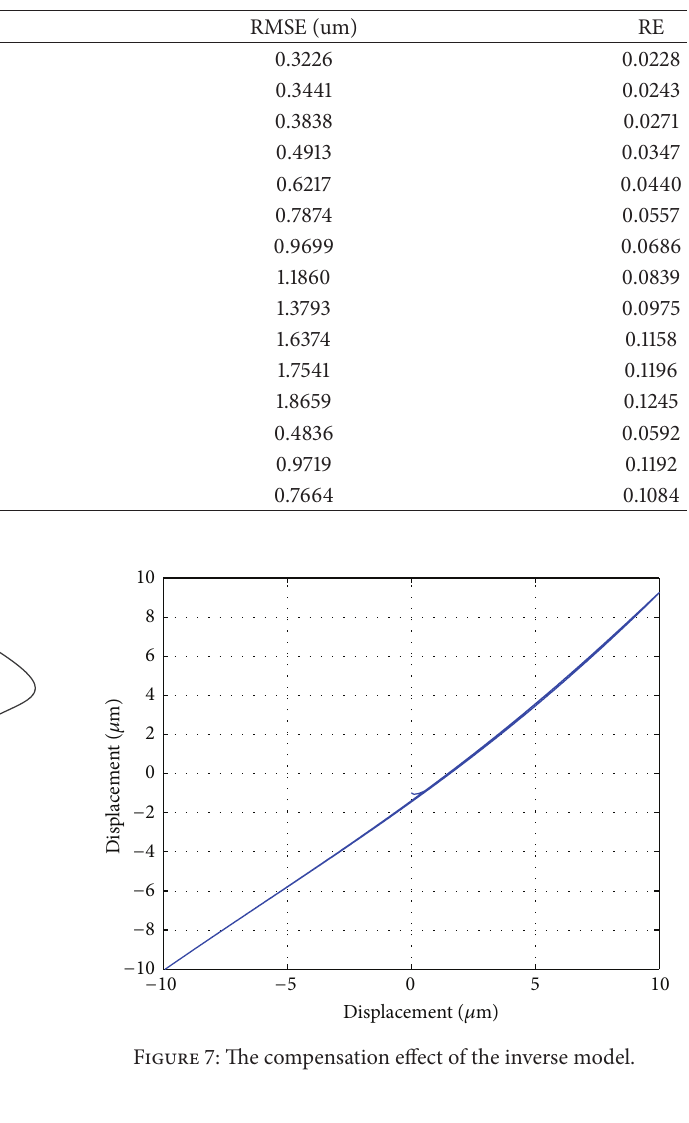
Table 2: Tracking control results.